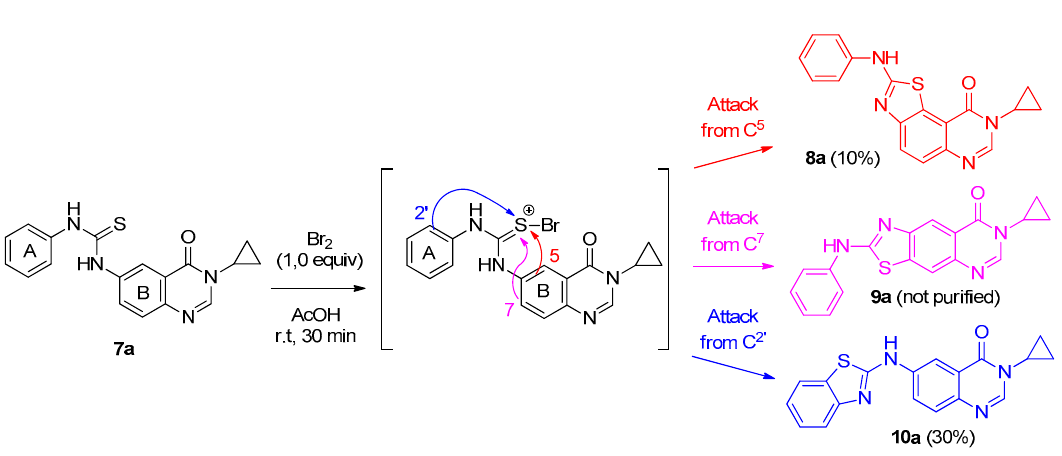
Molecules 2016 , 21 , 794